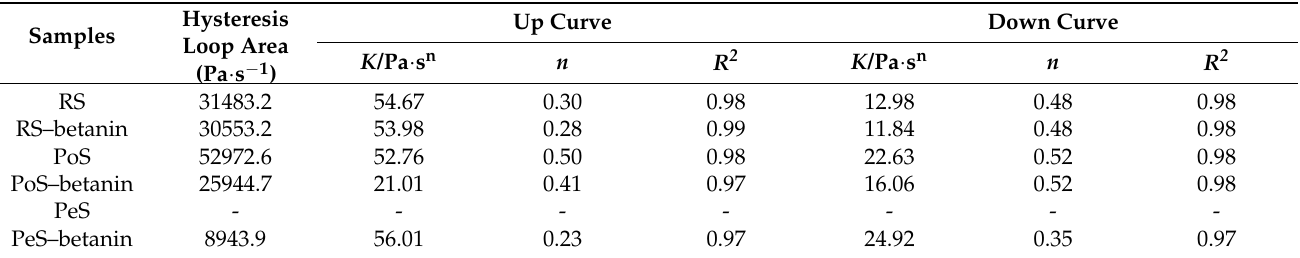
Figure 2. Shear rheology curves ( A ), storage moduli (G ′ ) ( B ), loss moduli (G ″ ) ( C ) and loss tangents (tan δ ) ( D ) of starches and starch–betanin samples determined by rheological measurements. RS: rice starch; PoS: potato starch; PeS: pea starch. Table 2. The steady shear rheological parameters of starches and starch–betanin samples.